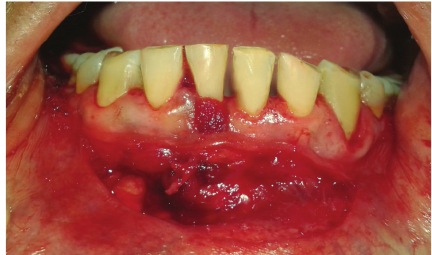
Figure 6: Periosteal Pedicle Flap placed on the area of recession via tunnel.